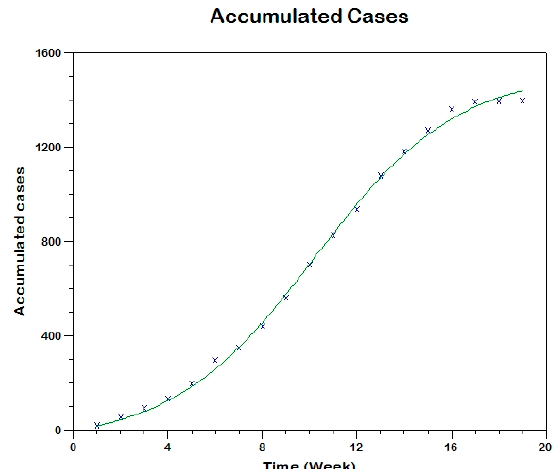
Figure 13. Model fit to the cumulative reported incidence of the second outbreak in Tolima-Colombia using Method 0.